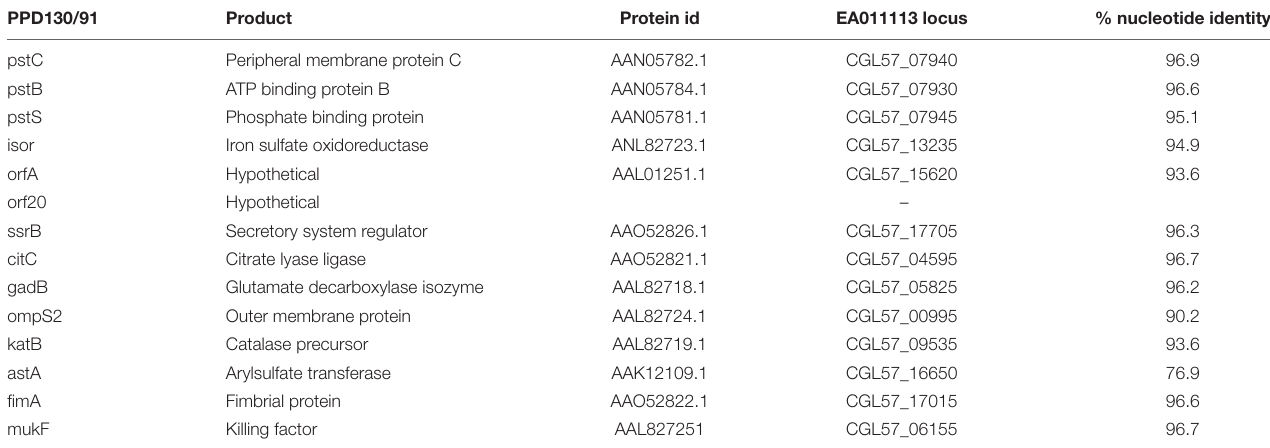
TABLE 1 | Virulence genes experimentally confirmed in E. piscicida, their protein id, their orthologs in EA011113 and the % nucleotide similarity following pairwise alignment with the Geneious algorithm. PPD130/91